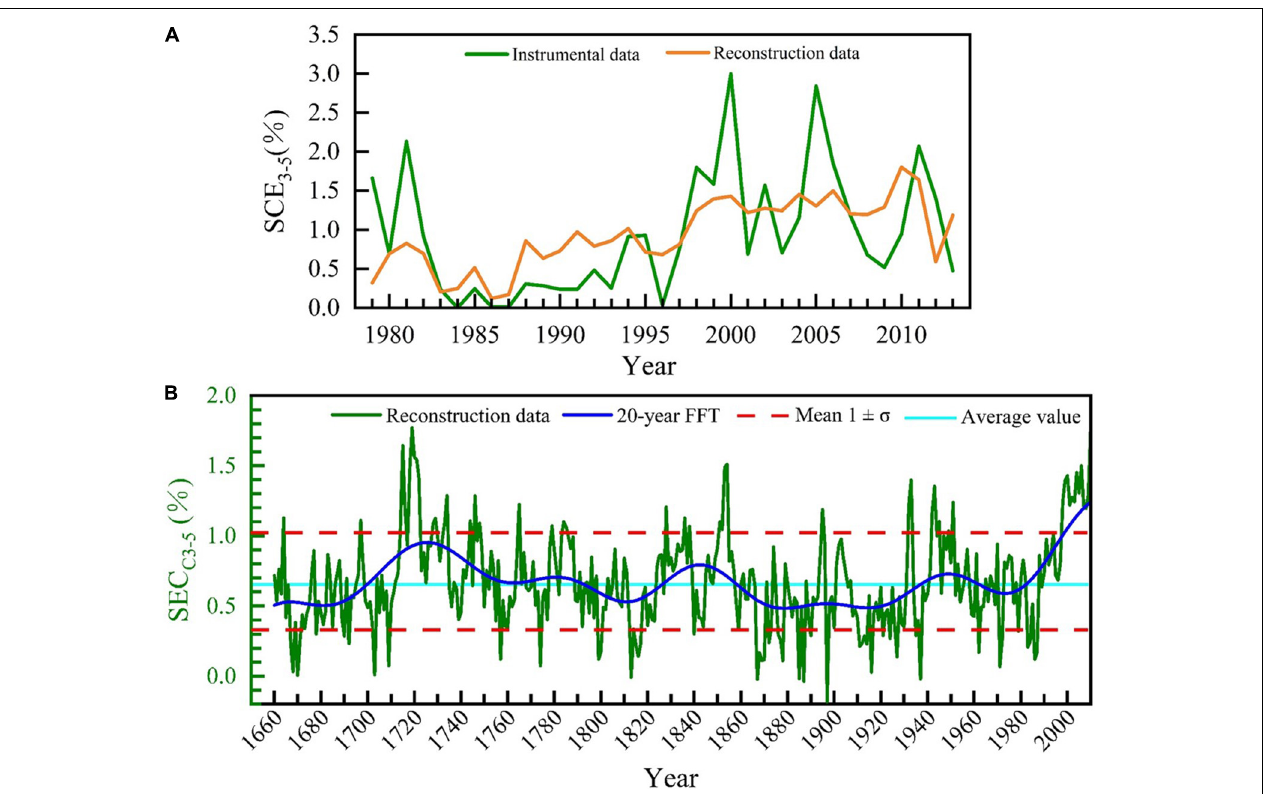
FIGURE 5 | The reconstructed SCE 3 − 5 at XQDV, SETP. (A) A comparison between the raw instrumental data and the raw reconstruction data (1979–2013) and (B) the reconstructed SCE 3 − 5 since 1660 CE and its 20-year moving average. The horizontal light-blue line indicates the mean value of the reconstruction during the period of 1660–2013, and the red broken lines indicate the mean ± 1 σ (standard deviation).